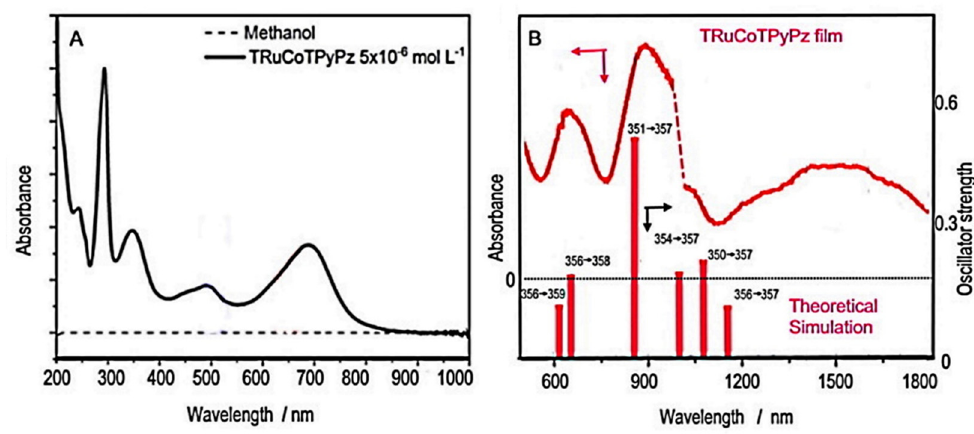
Figure 3. ( A ) Electronic spectrum of TRuCo(II)TPyPz in methanol solution, and ( B ) as molecular film of TRuCo(III)TPyPz onto GCE, including the theoretical bands from ZINDO/S simulation and their corresponding levels. The dotted line in ( B ) refers to instrumental artifact from the changes in the detector module.